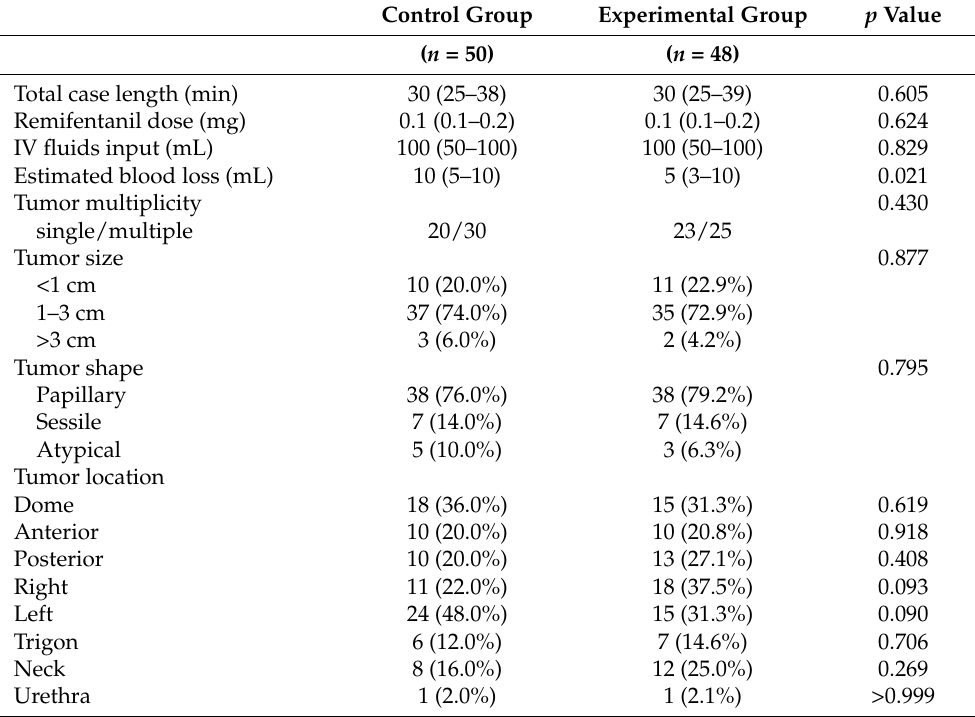
Table 2. Comparisons of intraoperative findings between the control and experimental groups.